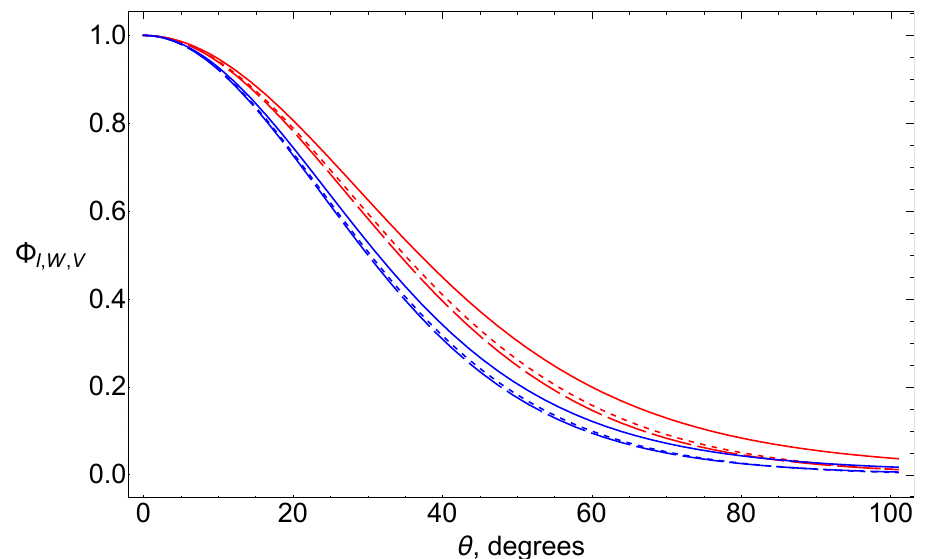
Figure 7. Example of the angular dependence Φ I , Φ W and Φ V (solid, dashed and dotted lines). The numerical calculations were carried out for the Henyey-Greenstein phase function ( g = 0.9) combined with the Rayleigh scattering matrix (from upper to lower curves, p / σ tr = 3 and 5).